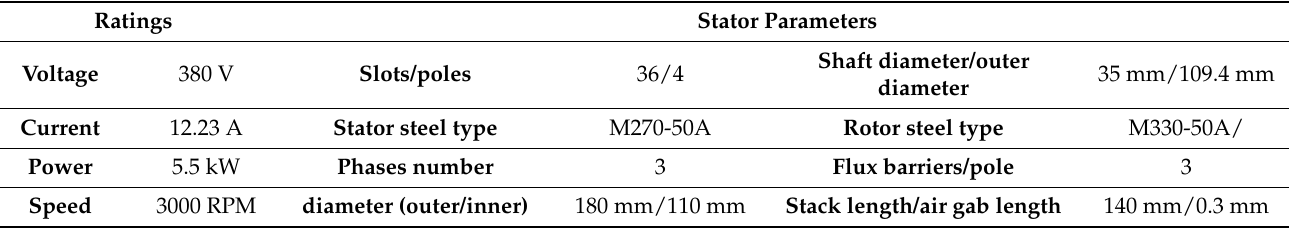
Table 2. SynRM geometrical